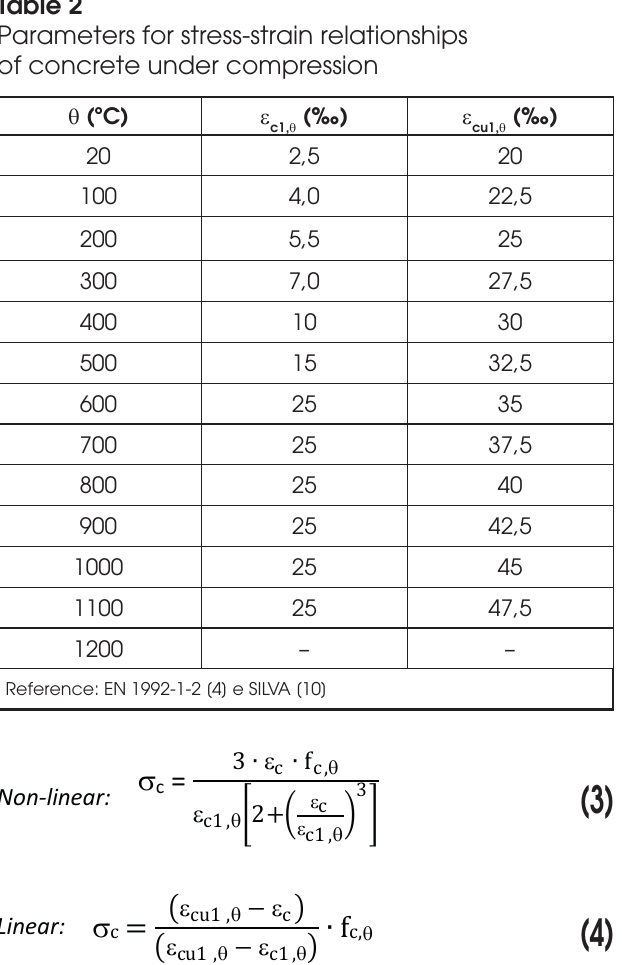
Values for the parameter f